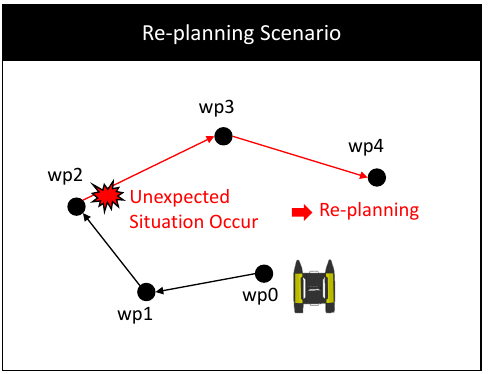
Figure 9. Simulation scenario for re-planning: One USV moves while performing reconnaissance for the given WPs. It was assumed that the mission fails as an unexpected situation occurs at wp2 and it is verified whether re-planning is successfully executed.